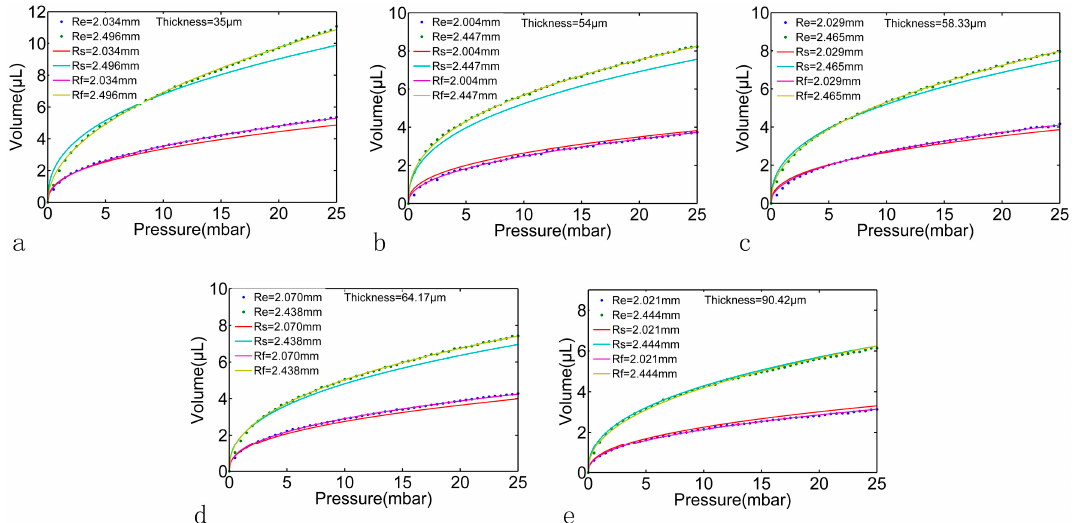
Figure 10. The experimental pressure-volume relationships of the PDMS membrane with different radius R and different thickness h . The “Re” dot plot indicate the results of the experiments and the “Rf” solid lines indicate the results of fitting the experimental data. The “Rs” solid line indicate the theoretical estimation using the same geometry parameters and Equations (13)–(15). Subplot ( a – e ) represent the measured thickness of the PDMS membrane from 35 to 90 μ m.